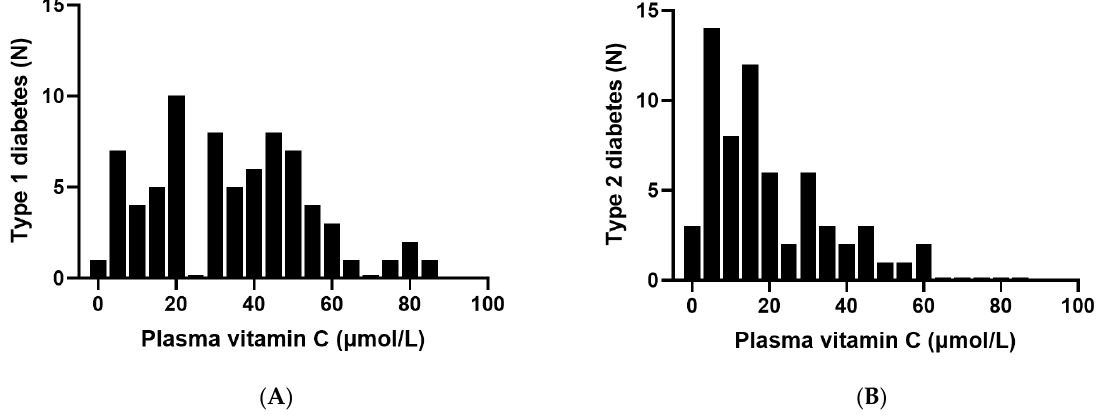
Figure 1. Frequency distribution of plasma vitamin C in patients with diabetes: ( A ) type 1 diabetes ( n = 73) and ( B ) type 2 diabetes ( n = 63).